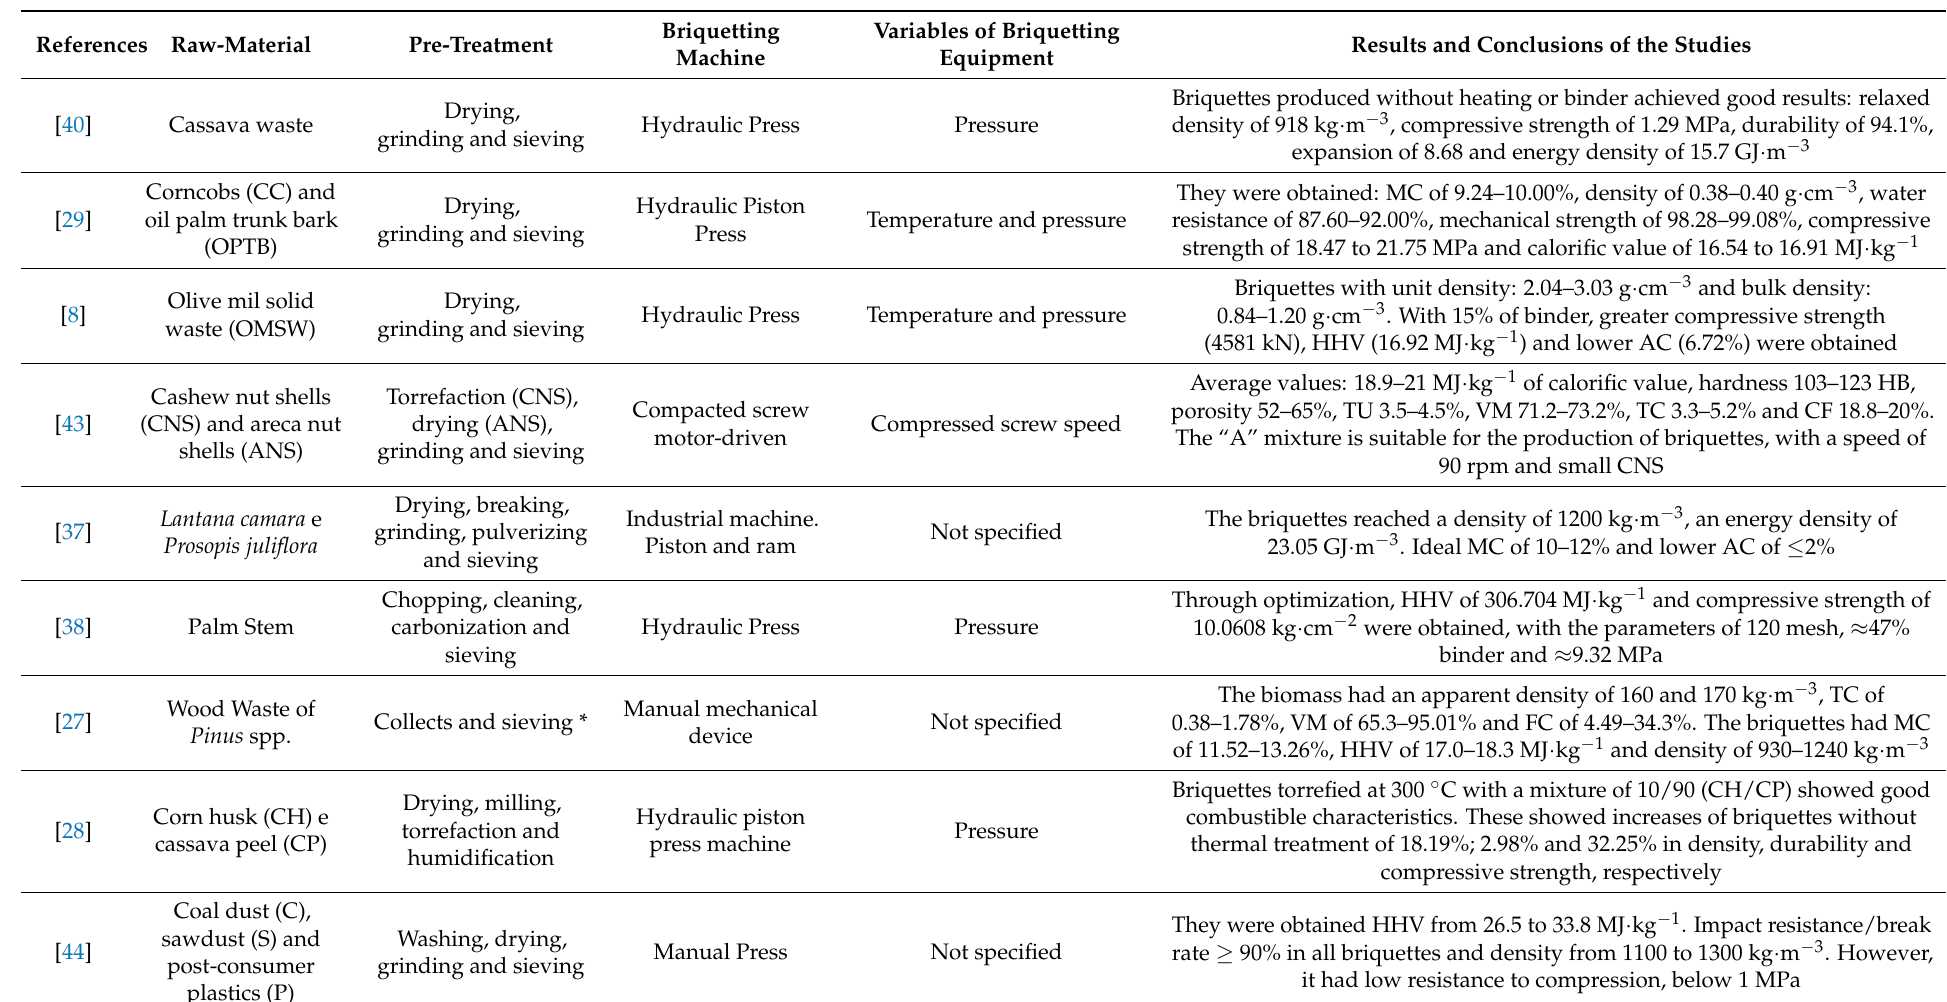
Table 1. Main briquette production